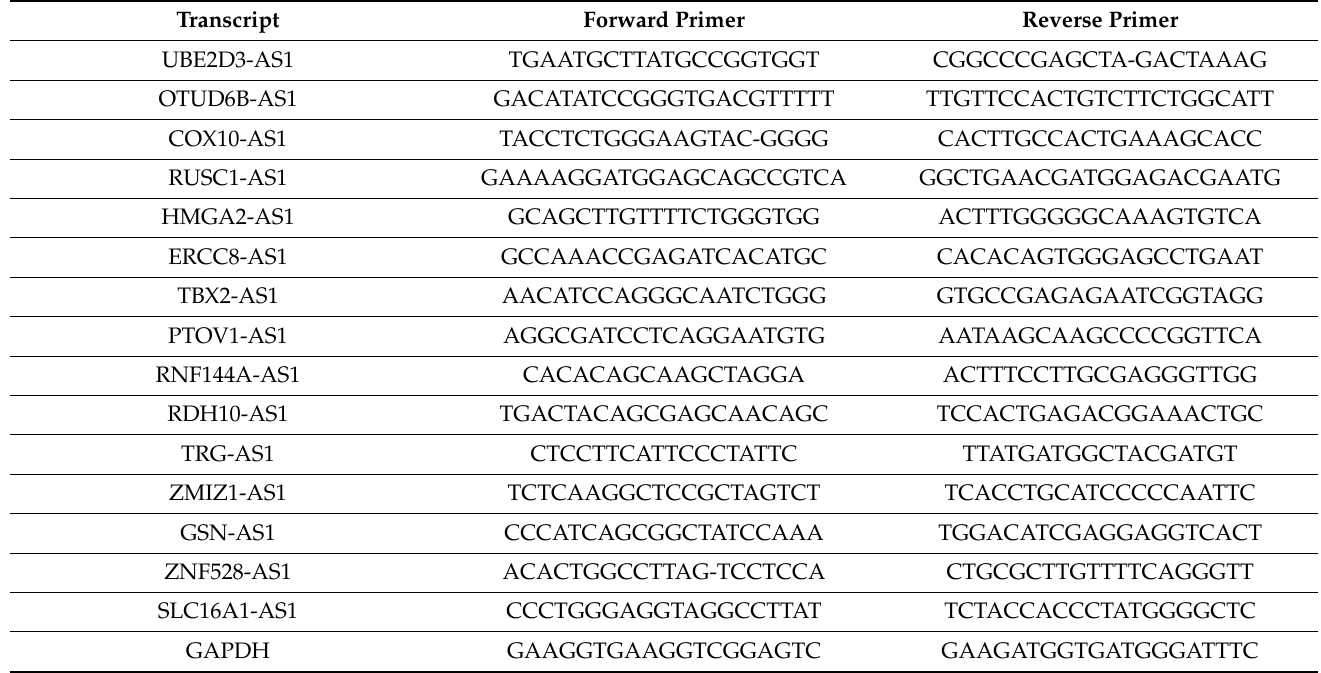
Table 1. Human primer sequences used in RT-qPCR.